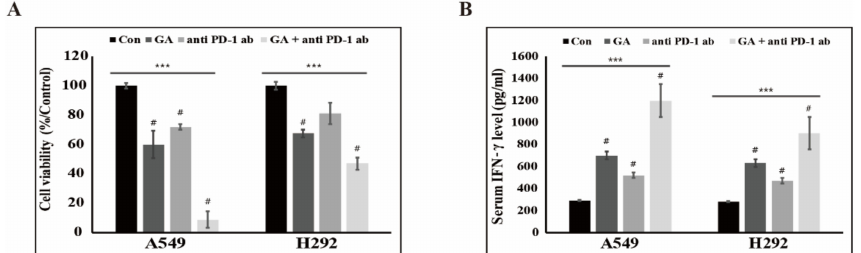
Figure 6. GA enhances the combination effect with anti-PD-1 mAb in an NSCLC-cell and peripheral blood mononuclear-cell (PBMC) coculture system. ( A ) The cell survival rates of NSCLC cells cocultured with PBMCs were examined after treatment with mock, GA (A549: 200 µ M; H292: 50 µ M), anti-PD-1 mAb (5 µ g / mL), or both GA and anti-PD-1 mAb for 48 hours. *** p < 0.001 (ANOVA); # p < 0.001 vs. control.